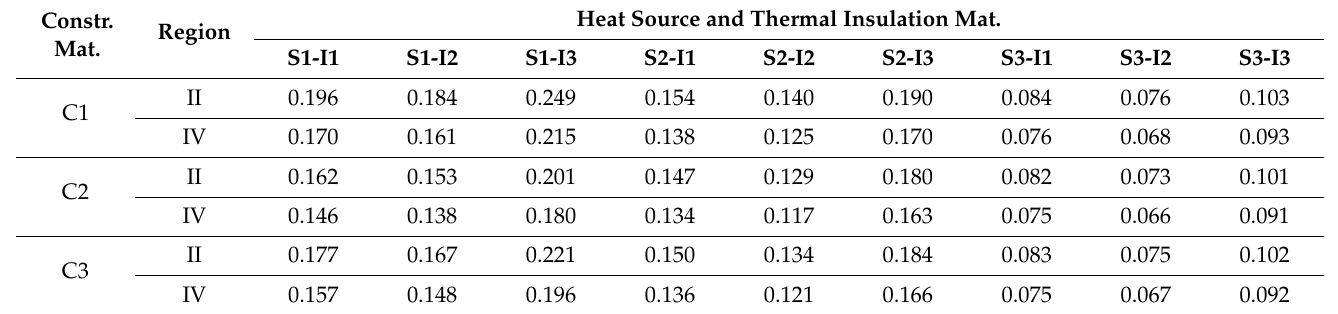
Table 11. Optimum heat transfer coefficient U MKopt (W/m 2